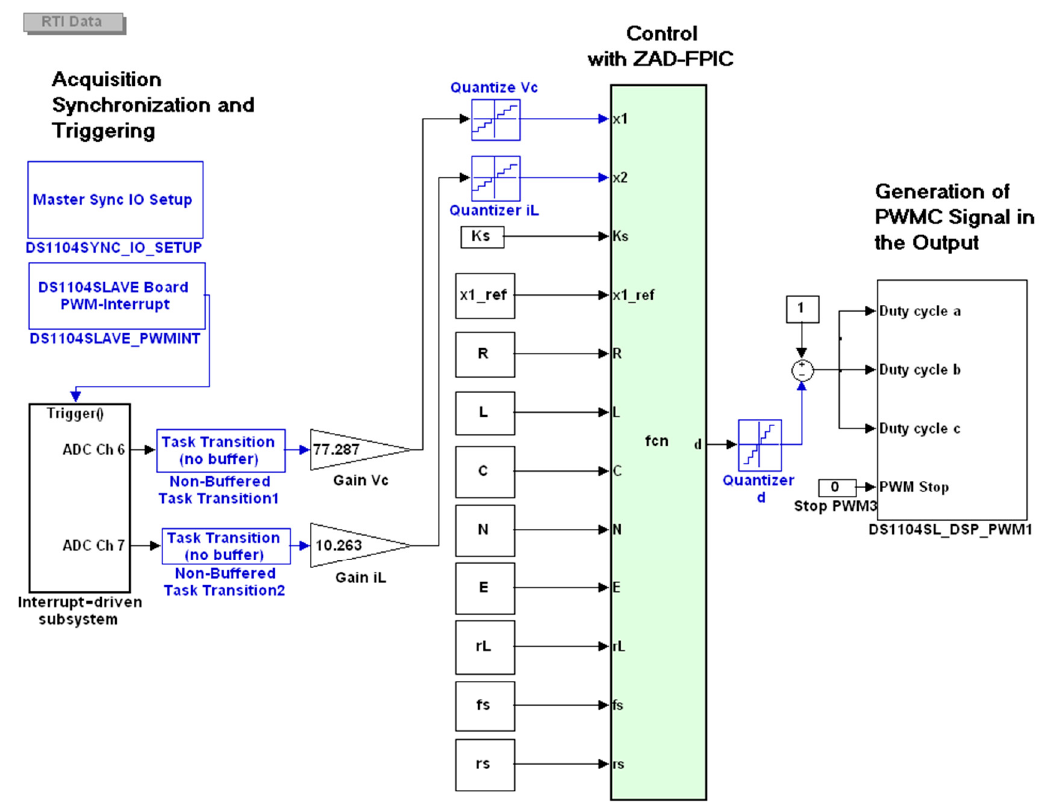
Figure 10. Software developed in Simulink to control the buck converter.